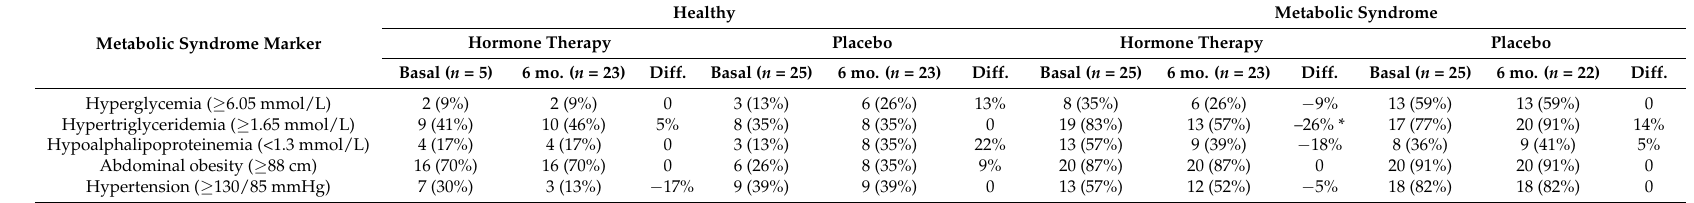
Table 3. Percentage change of metabolic syndrome markers after 6